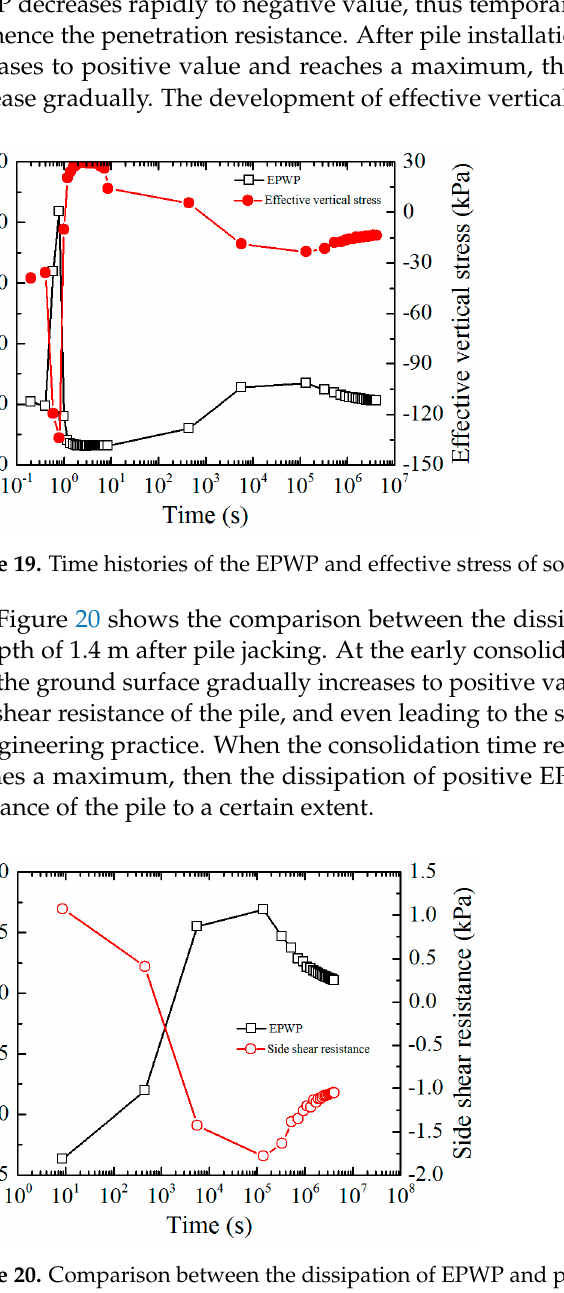
Figure 21. Time histories of the EPWP and effective stress of soil at depth of 7.5 m at z p = 7.8 m. Figure 22 shows comparisons between the dissipation of EPWP and pile set-up at depth of 7.5 m under various soil permeability coefficients after pile jacking. The side shear resistance of the pile increases gradually with the dissipation of positive EPWP. The side shear resistance of the pile is positively correlated to k s . Besides, at the initial consoli- dation phase, as the effective stress of the surrounding soil at the selected depth is close to zero, the side shear resistance of the pile calculated by Equation (14) is also close to zero. In engineering practice, the adhesion at the pile–soil interface cannot be neglected. The adhesion reduces due to the surrounding soil in remolded state during pile jacking and recovers due to the aging effect after pile installation.